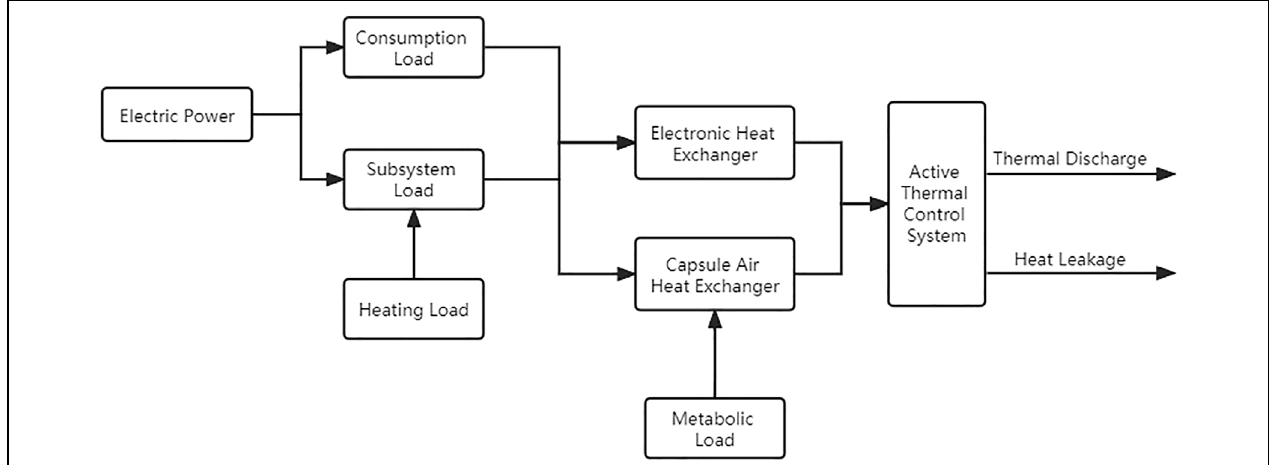
FIGURE 1 | Thermo-fluid